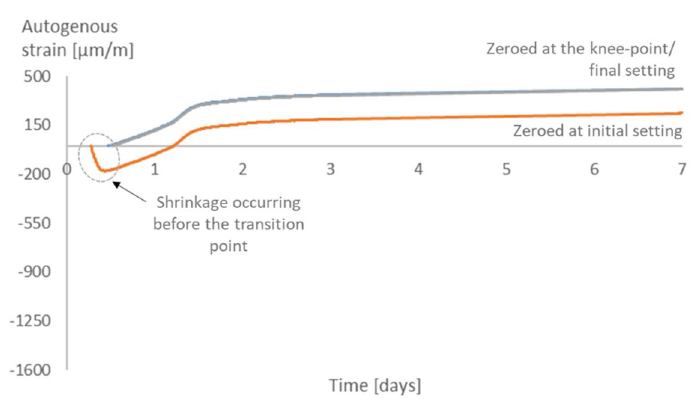
Figure 14. Autogenous strain for different time-zeros in SAP2.